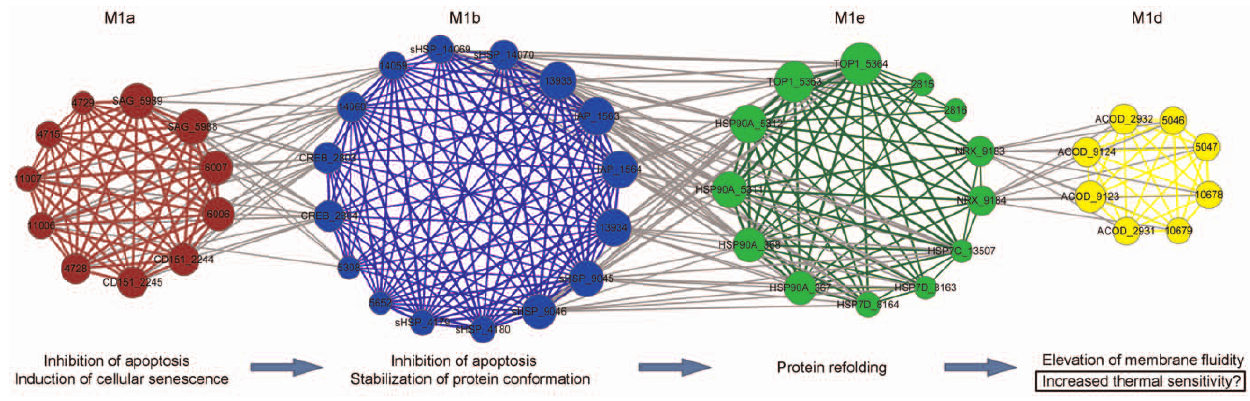
Figure 3. Network visualization of submodule interactions. Each node represents a hub gene. Hub genes derived from the same submodule are labelled in the same color. Hub genes are connected by an edge if the topological overlap between them is more than 0.13. Interactions (i.e. edges) between modules are labelled in grey.